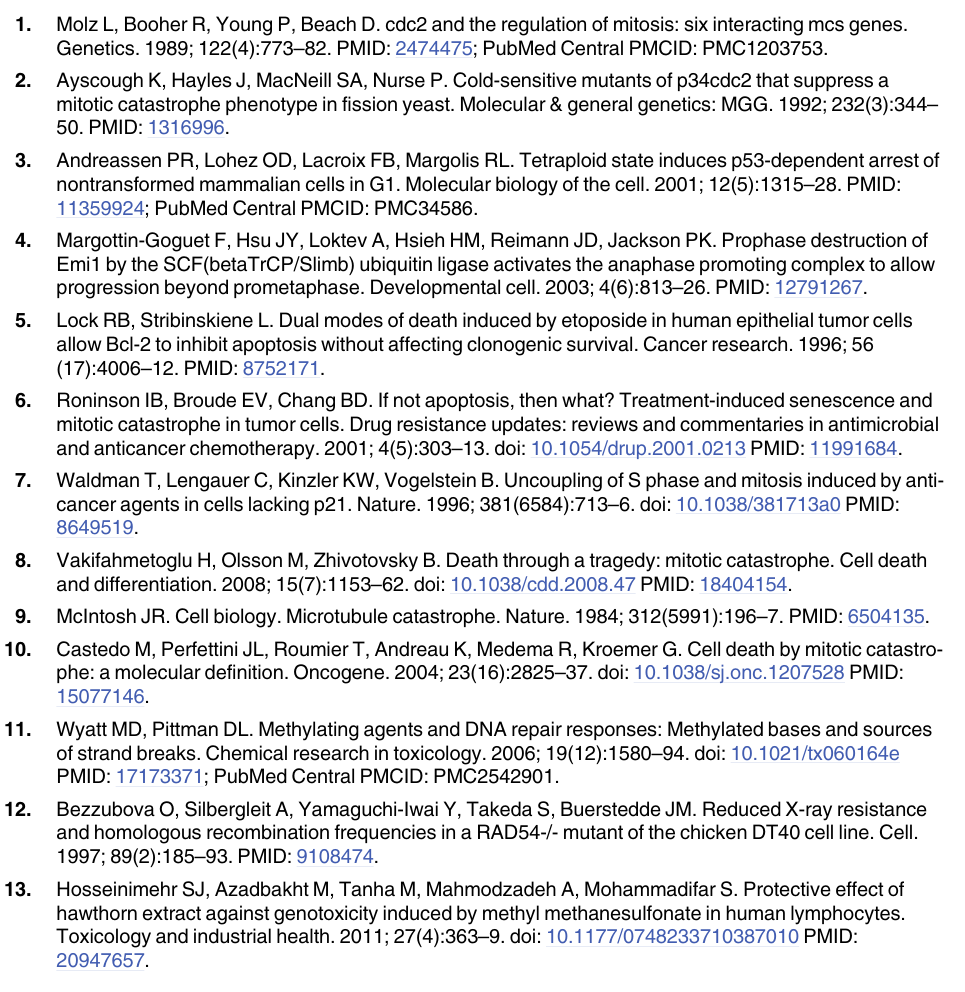
S1 Fig. Knockdown of PSPC1 influences MMS-induced cell cycle redistribution. HeLa cells were transfected with 2 nd set of siPSPC1 or siControl for 24 h, then treated with 0 μ M and 100 μ M of MMS for 12 h. The expression of PSPC1 was examined by Western blot (A) and analyzed by flow cytometry